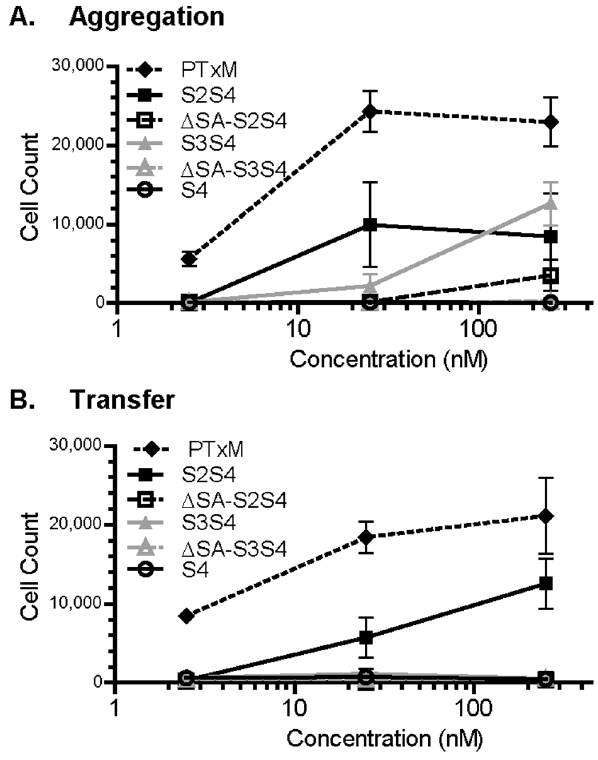
Figure 7. Effect of differing concentrations of recombinant PTxB subunit dimers on Jurkat aggregation and membrane transfer. Results represent the mean of three independent assays with standard deviation. A. Aggregation. B. Membrane transfer.